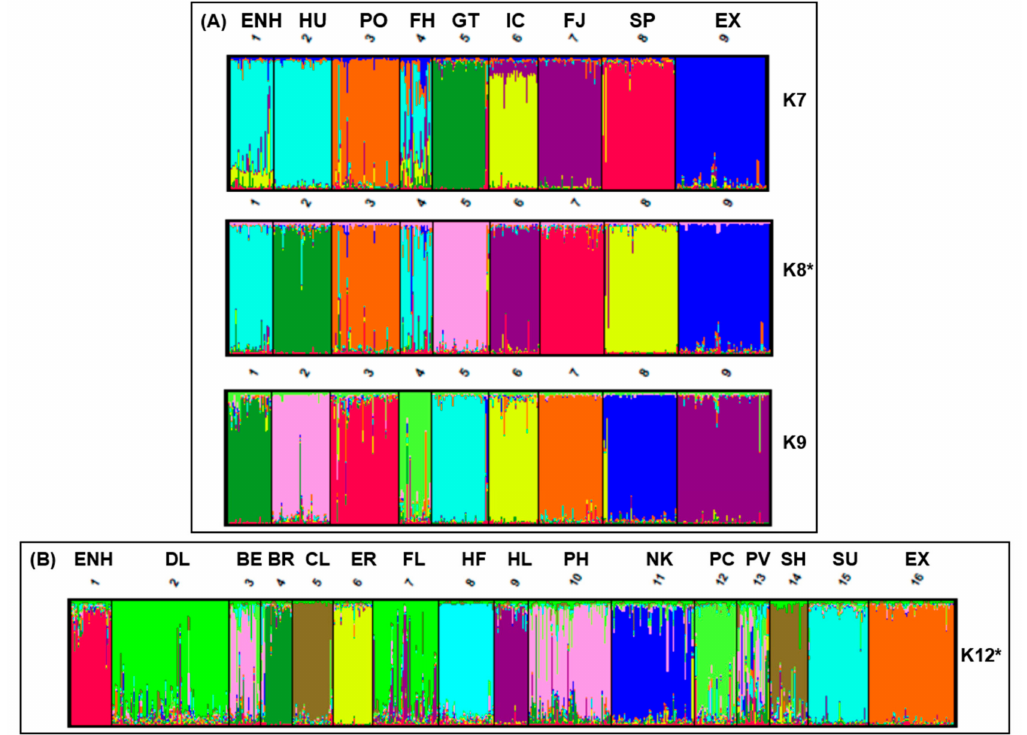
Figure 3. STRUCTURE analysis of the Estonian Native Horse (ENH) with ( A ) the 8 Northern European pony breeds in Group A at K = 7, K = 8 and K = 9, and ( B ) with the remaining 14 breeds in Group B and Exmoor Pony at K = 12. Optimal population clustering for Group A and B indicated by asterisks (*). Breed abbreviations are listed in Figure